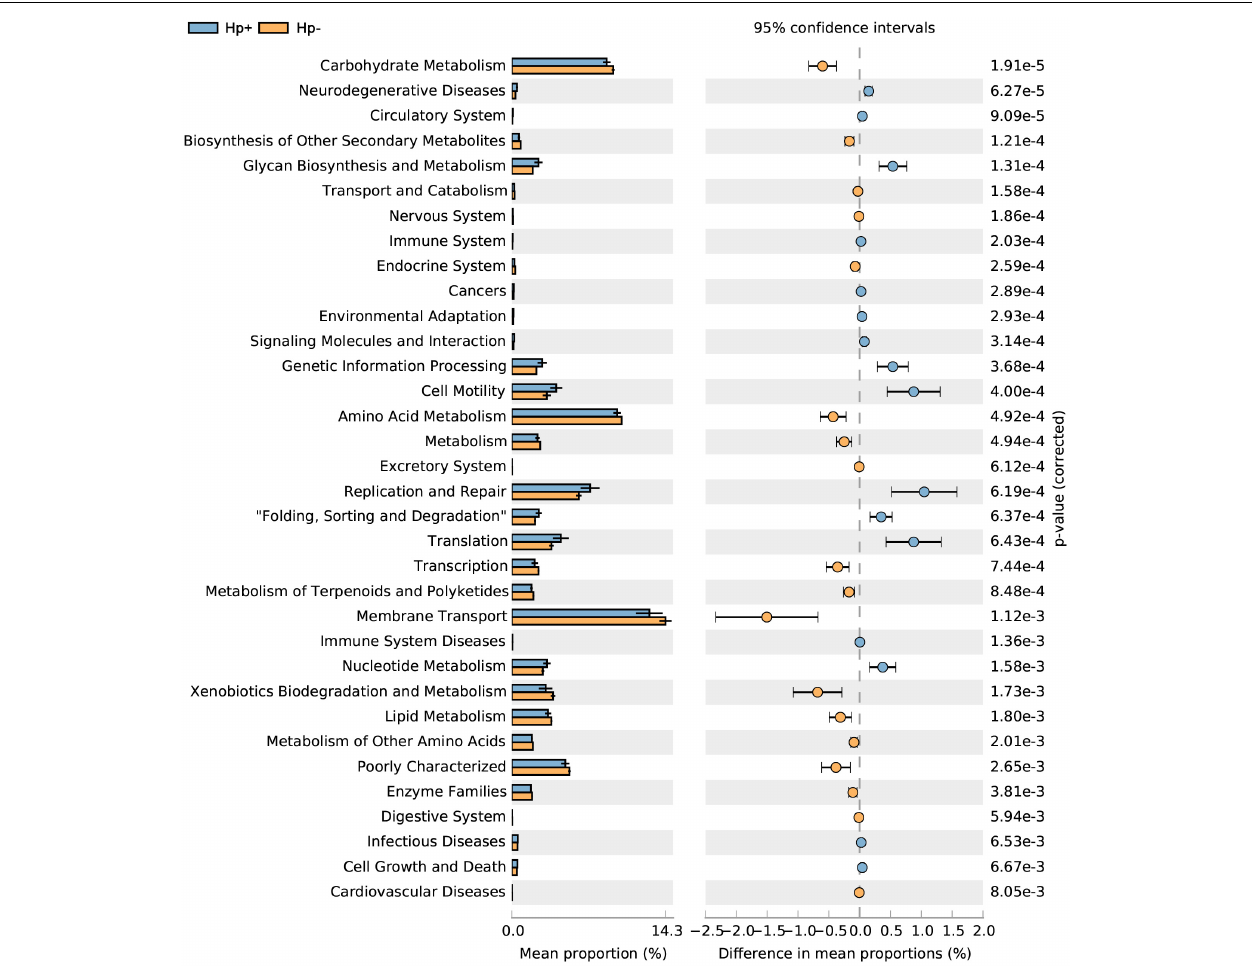
FIGURE 6 | Statistical Analysis of Metagenomics Profiles (STAMP) was used to analyze the different bacterial functions between H. pylori positive group and H. pylori negative group at the Kyoto Encyclopedia of Genes and Genome (KEGG) level 2. Hp+, H. pylori positive group; Hp-, H. pylori negative